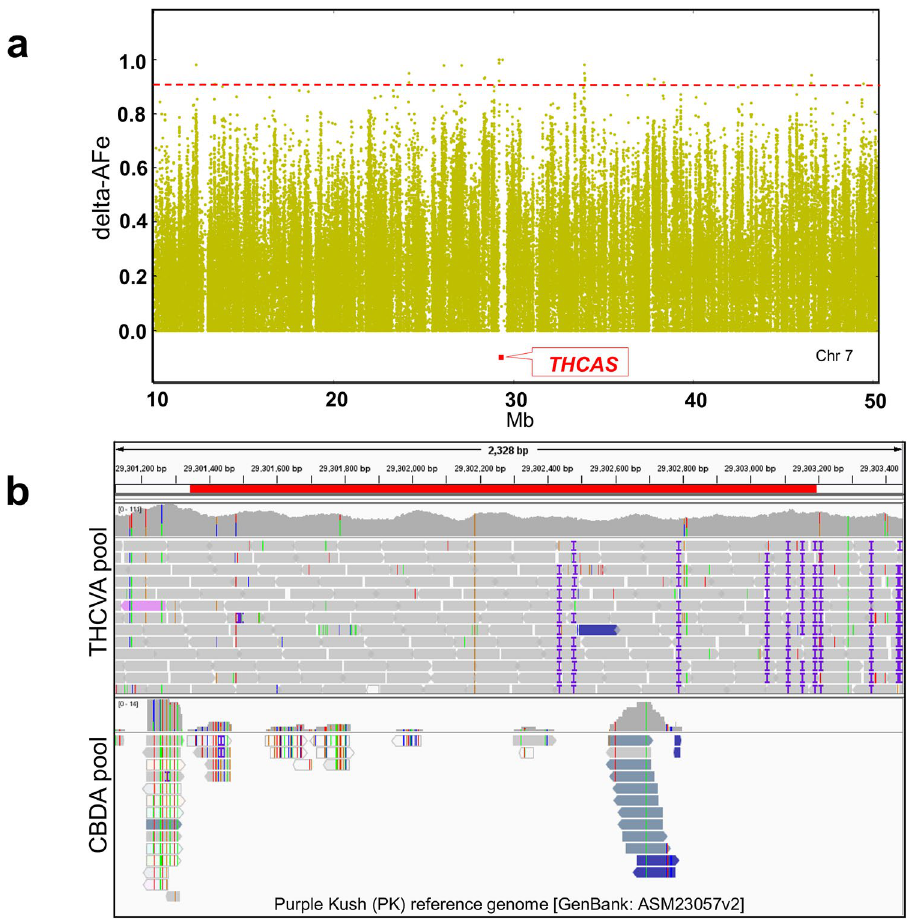
Figure 3. Non-homologous genomic region encompassing the THCAS locus. ( a ) Delta AFe values form a gap that overlaps the coordinates of the THCAS locus. delta-AFe is the absolute difference between AFe of CBDA and THCVA pools. ( b ) Integrative Genomics Viewer (IGV) snapshot of the THCAS locus. Reads from the THCVA pool were mapped to the PK reference sequence but reads for this region were absent from the CBDA pool; delta-AFe plotted by coordinate along chromosome seven of the Cannabis sativa L. var. Purple Kush (PK) genome. Bold red line indicates position of the THCAS locus. Red dotted line indicates delta-AFe of 0.9.